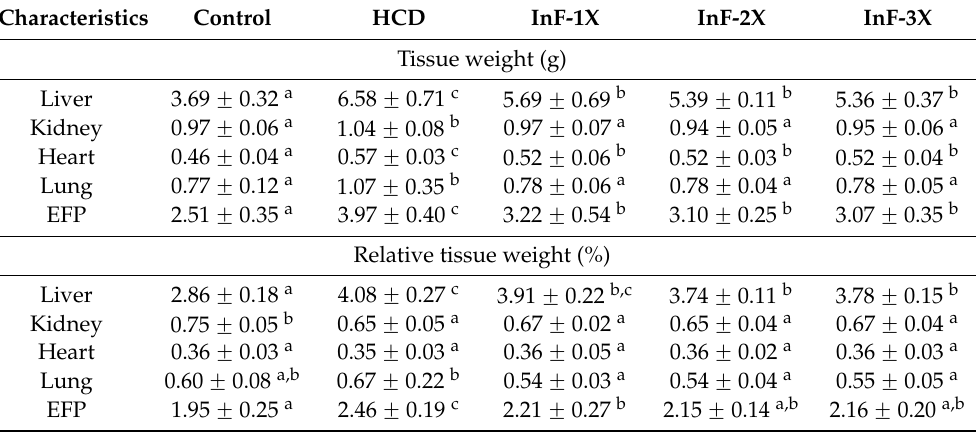
Table 2. The effects of InF supplementation on body composition.